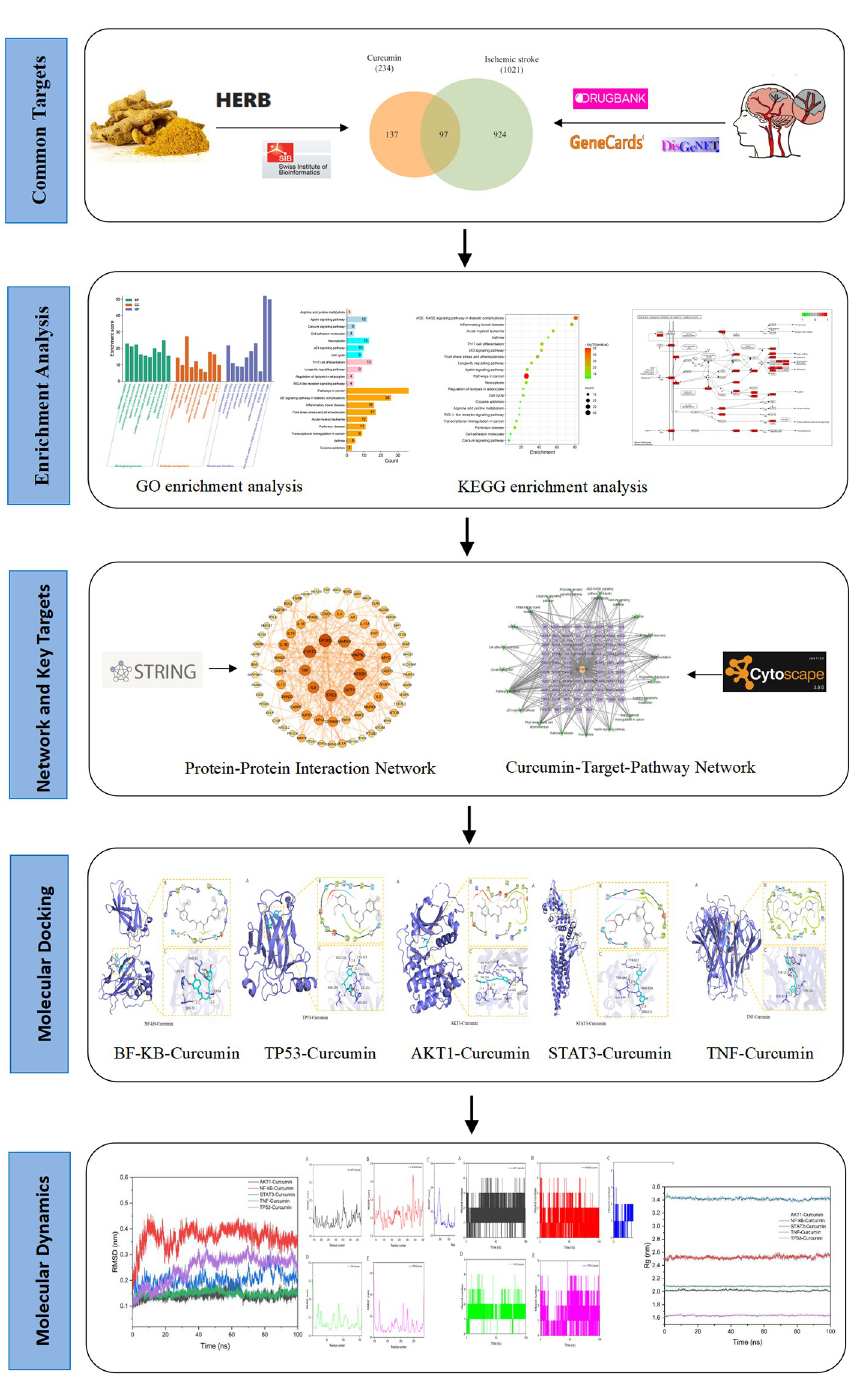
Fig 1. Flow chart of network